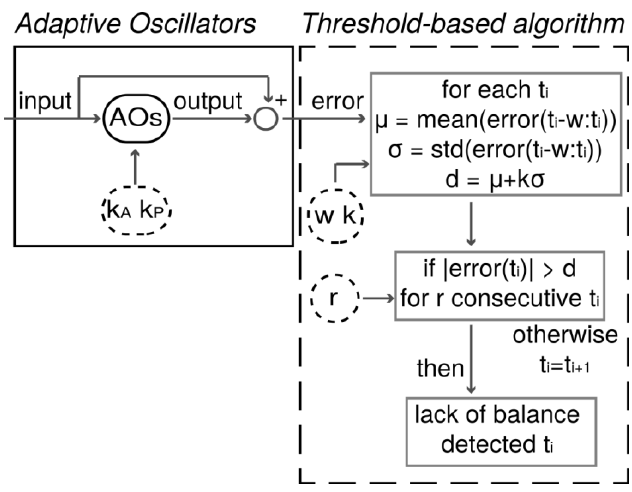
Figure 2. Pre-impact detection algorithm (PIDA) composed of a set of adaptive oscillators (AOs) (box on the left) and the adaptive threshold-based algorithm (dashed box on the right). Tuning parameters (i.e., k A , k P , w , k and r ) are depicted in dashed ovals.